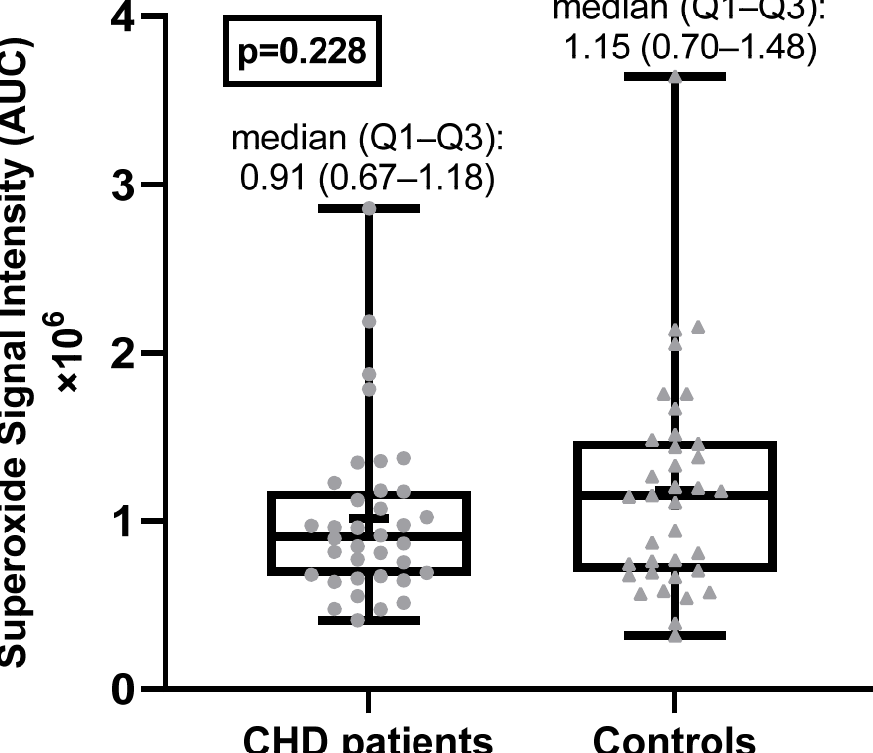
Figure 1. Superoxide anion radical levels in CHD patients and healthy controls. AU = arbitrary units.